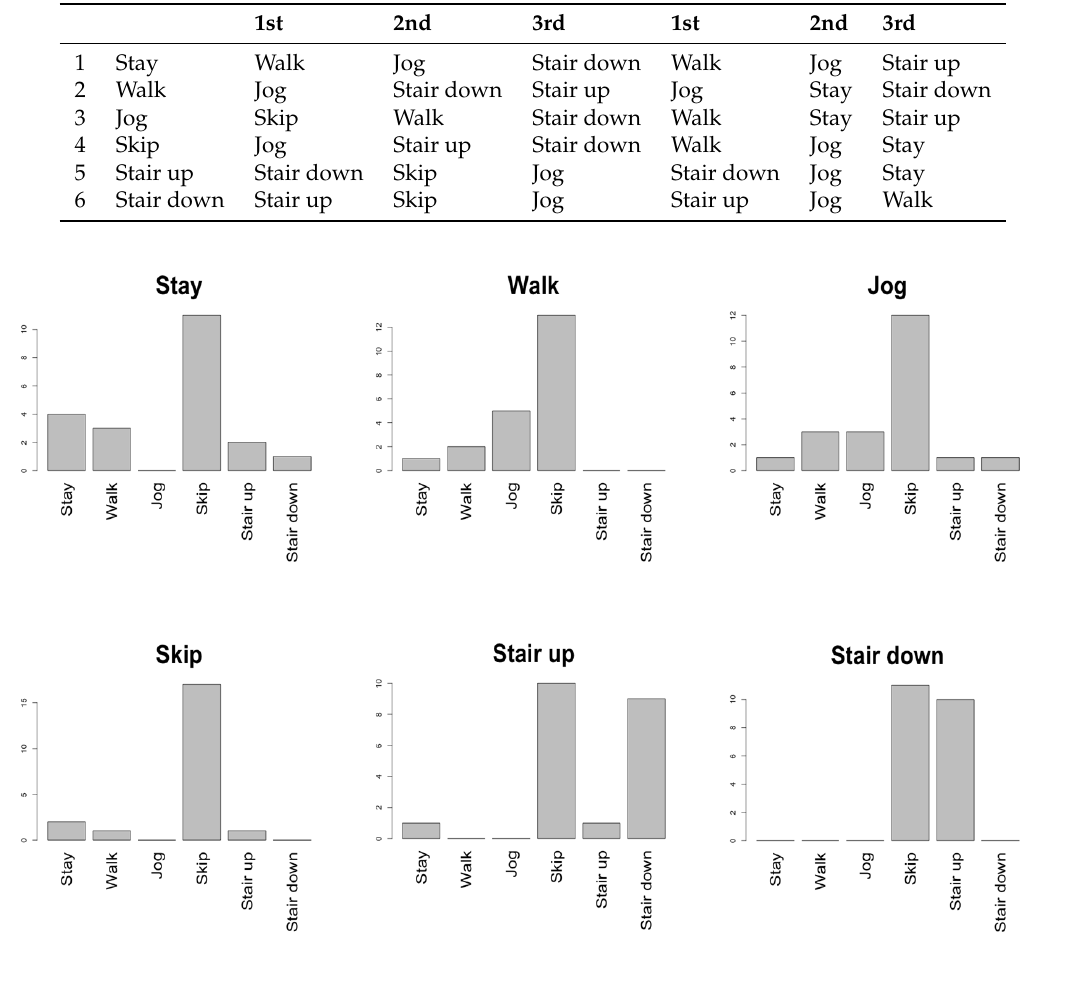
Figure 4. Histogram of the nearest classes appearing in HASC data for each sample in the set of expanded word embedding